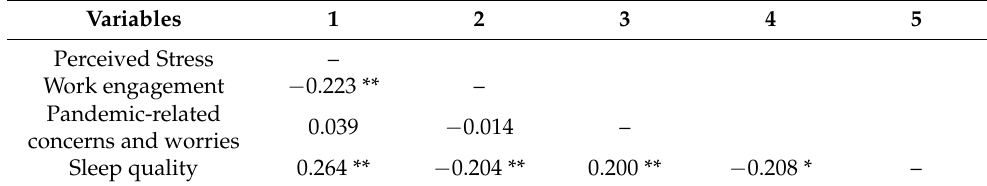
Table 2. Spearman rank correlations ( n =